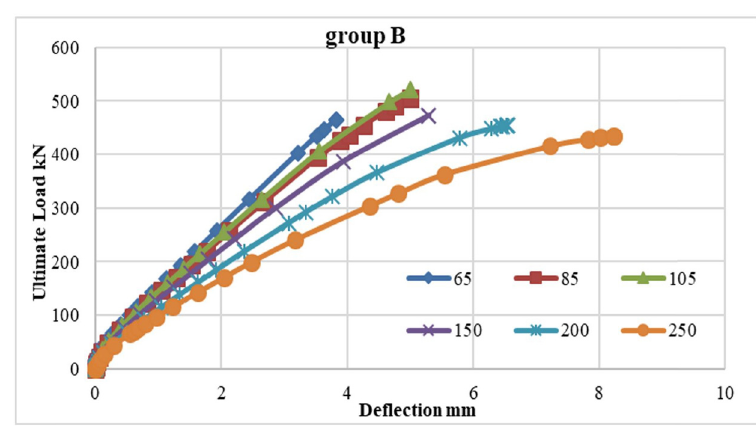
Figure 11: Load – de fl ection for the specimens of Group